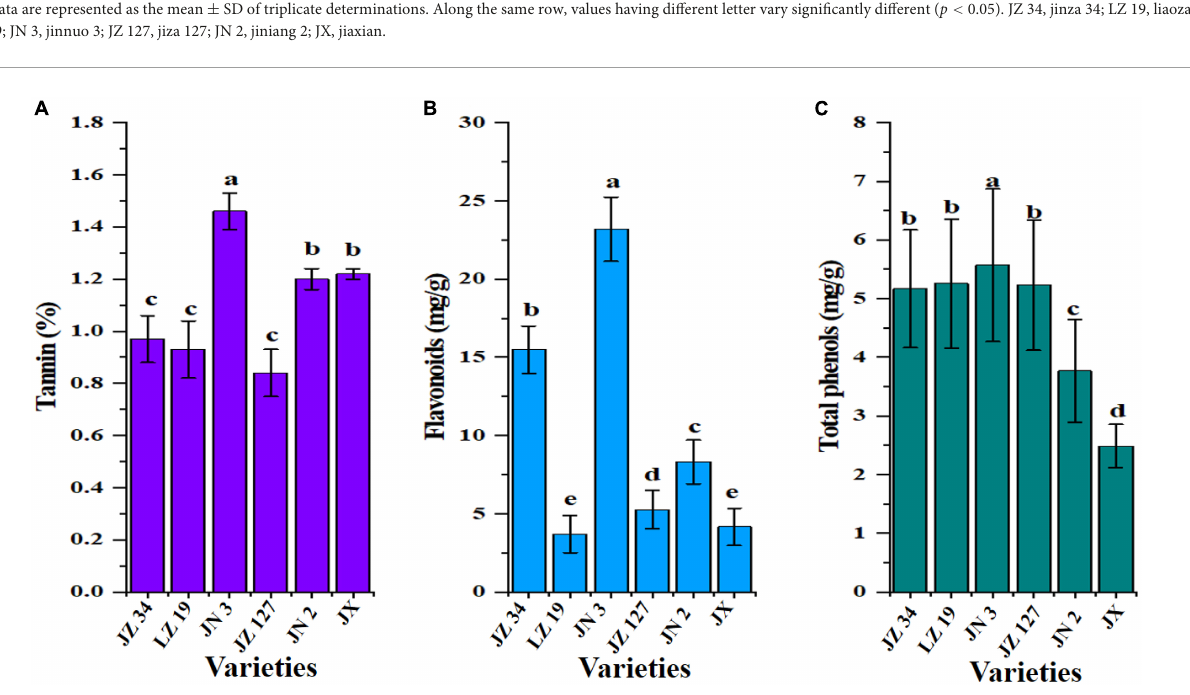
FIGURE4 Anti-nutritional factors of six sorghum grains, tannin (A) , flavonoids (B) , and total phenols (C) . JZ 34, jinza 34; LZ 19, liaoza 19; JN 3, jinnuo 3; JZ 127, jiza 127; JN 2, jiniang 2; JX, jiaxian. The data showed the mean of three replications, and error bars are standard deviations. Different letters (a–e) indicate there were significant differences ( p < 0.05) in the LSD mean comparisons between the treatments